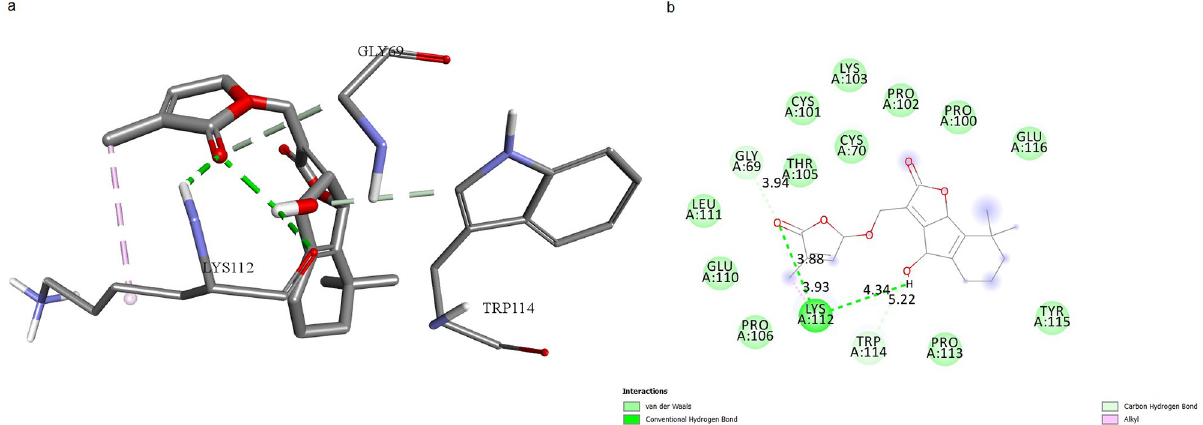
Fig 1. mTNF α -hTNFR1 interaction with Orobanchol. a . 3D shape of mTNF α -hTNFR1 interaction with Orobanchol. b . Illustration of hydrophobic bond formation between Orobanchol and the mTNF α -hTNFR1 complex. Orobanchol forms 2 hydrogen bonds with LYS112 of mTNF α .